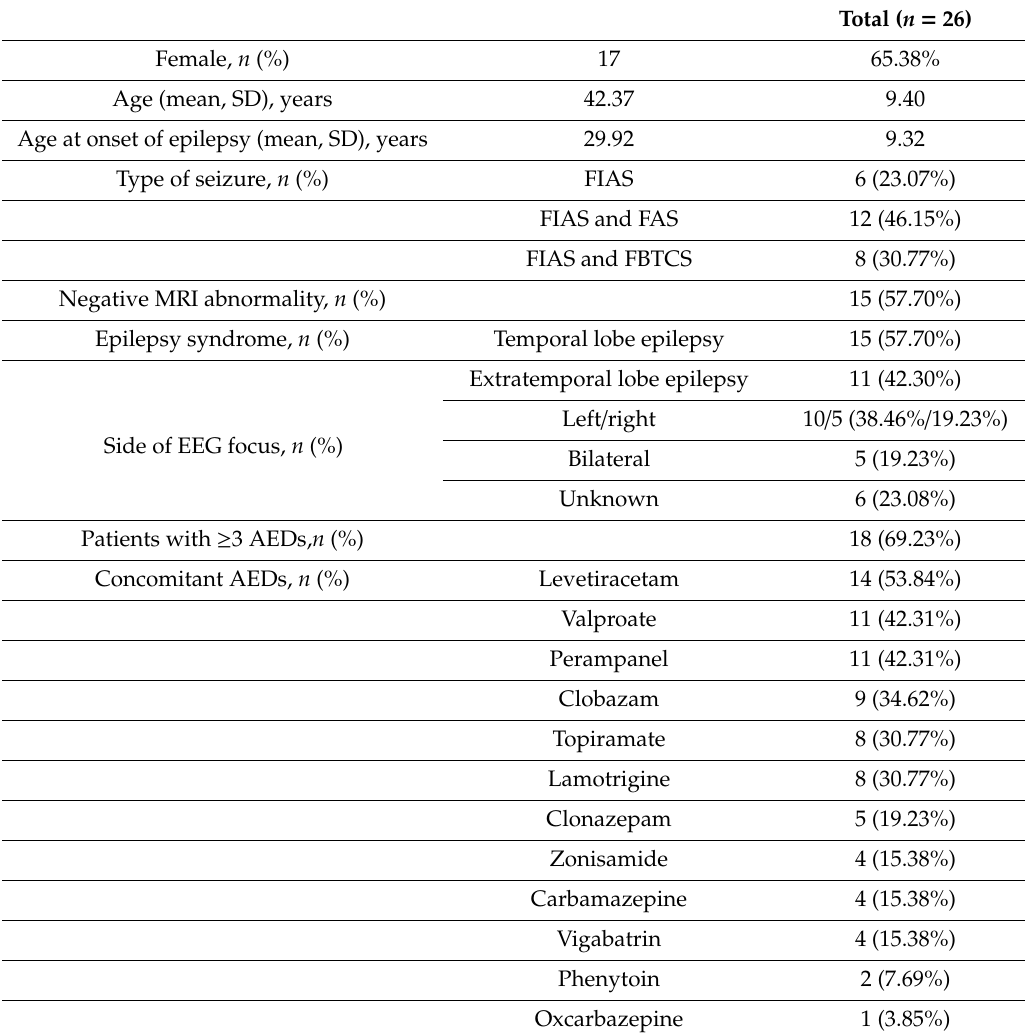
Table 1. Baseline characteristics of the